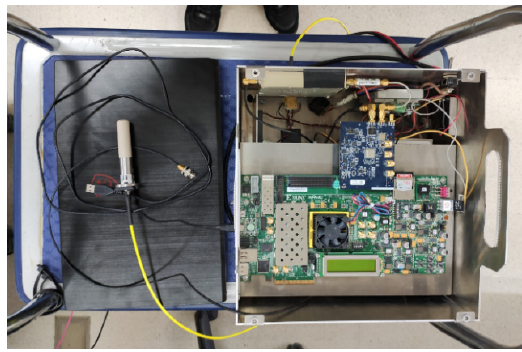
Figure 2. Zenithal view of the receiver without its cover.